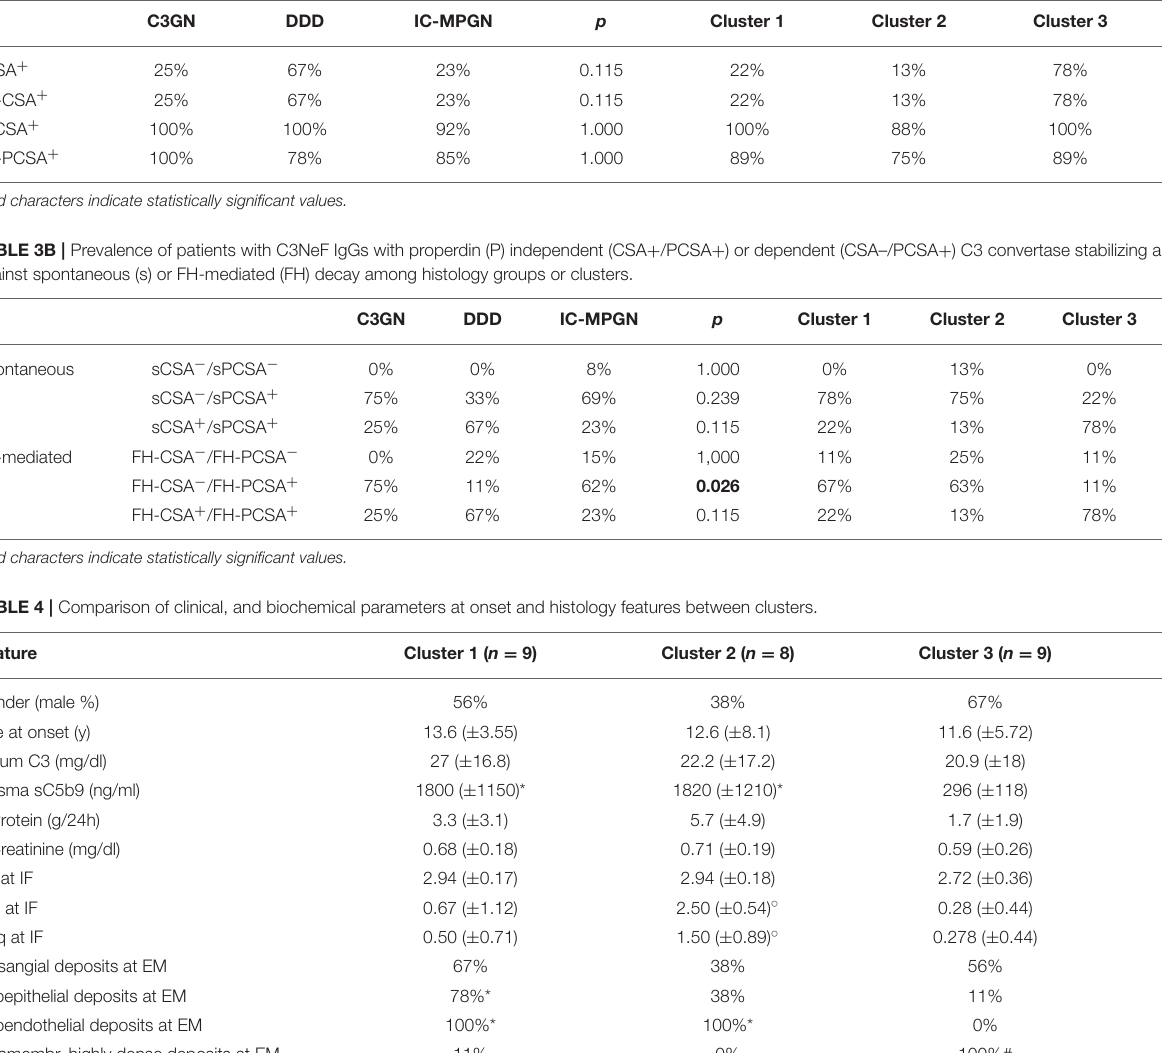
TABLE 3A | Prevalence of patients with C3NeF IgGs with C3 convertase stabilizing activity (CSA) against spontaneous (s) or FH-mediated (FH) decay in the absence (sCSA, FH-CSA) or in the presence of properdin, (sPCSA, FH-PCSA) among histology groups or clusters.